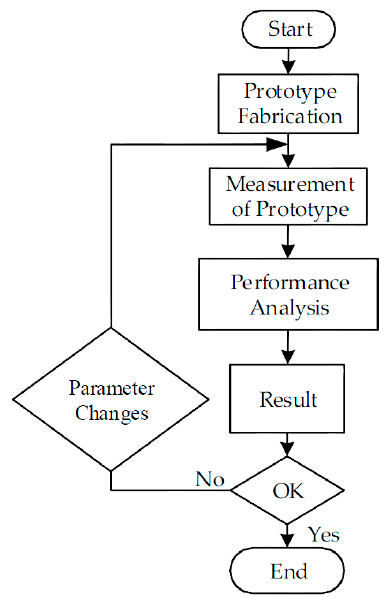
Figure 9. Flowchart of experimental process.